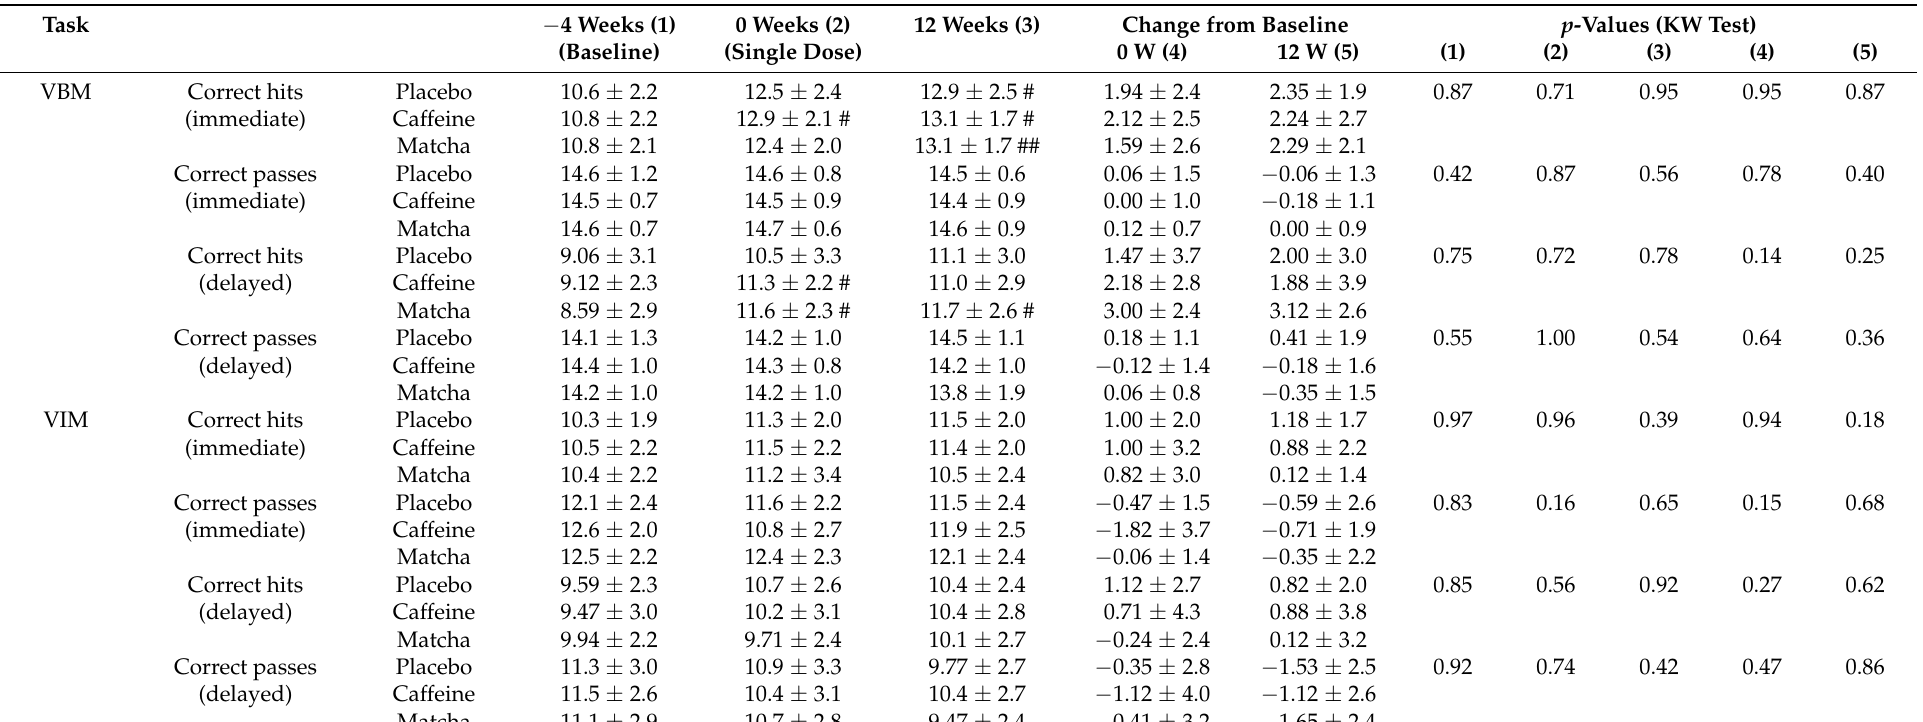
Table 4. Effect of matcha or caffeine intake on memory-related